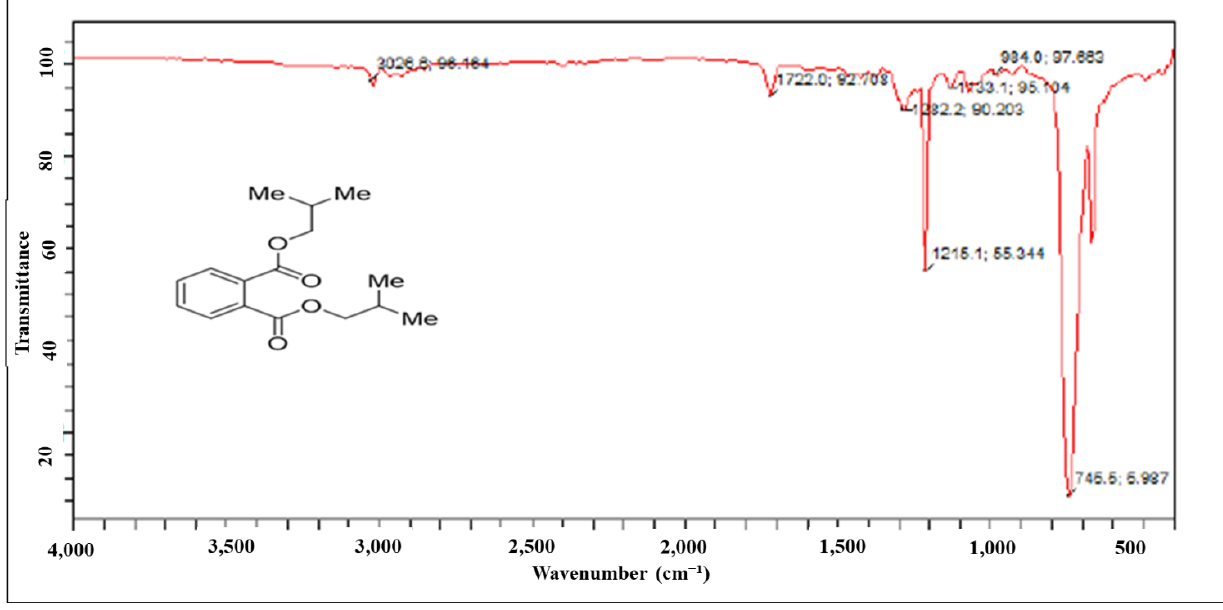
Figure 5. FT-IR (Fourier-transform infrared) spectrum of the BDCe fraction isolated from Obea fraction of O. bracteata.